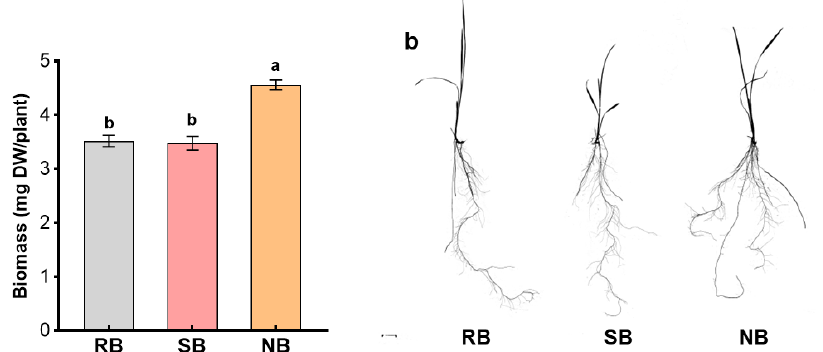
Figure 4. Root biomass ( a ) and morphology ( b ) of penoxsulam-resistant barnyardgrass ( RB ) in the root exudates of penoxsulam-susceptible barnyardgrass ( SB ) and normal barnyardgrass ( NB ). Values plotted are means plus/minus SE. Columns with the same letter are not significantly different at p < 0.05 according to ANOVA, followed by Tukey HSD tests.